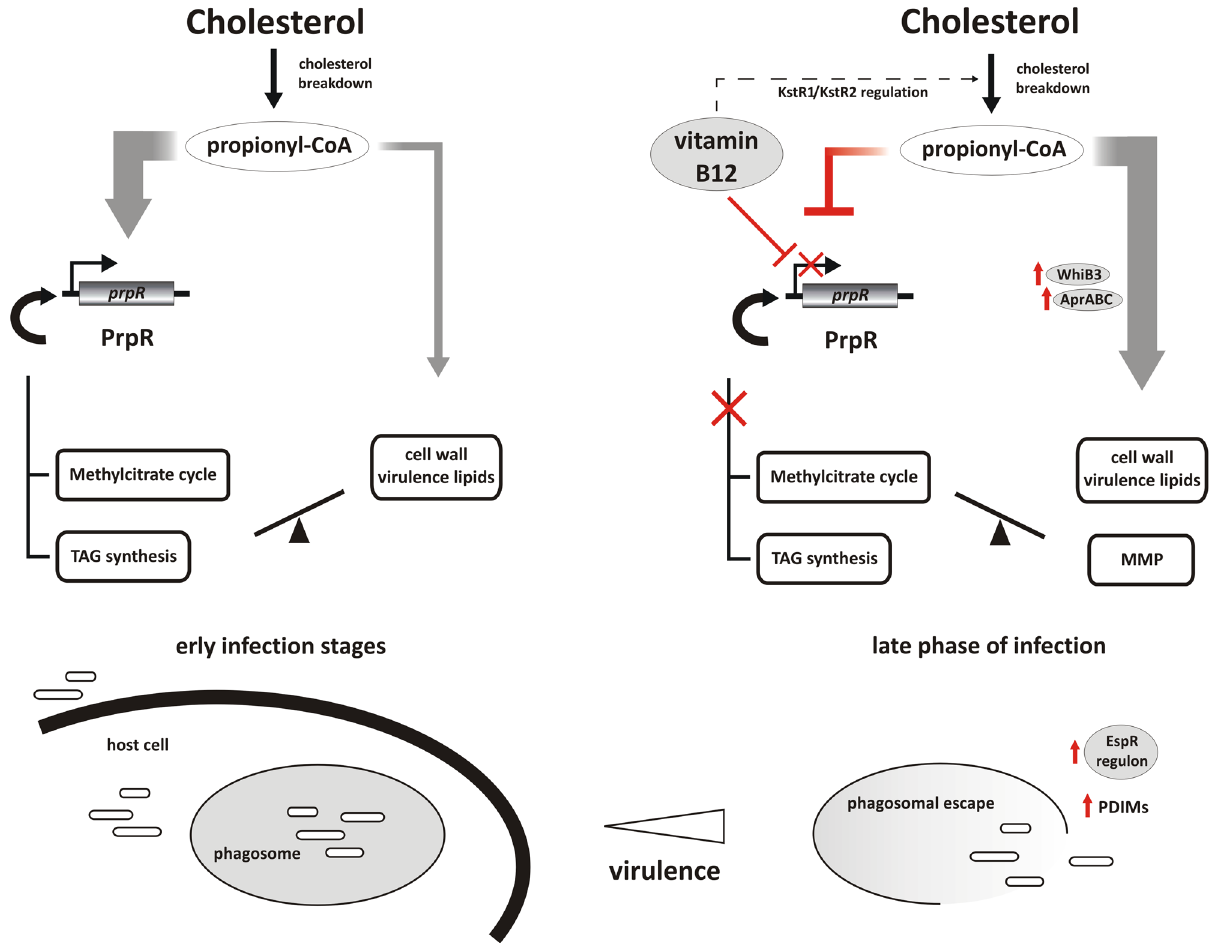
Figure 6. The role of vitamin B 12 and PrpR joint action in the channeling of propionyl-CoA and virulent phenotype induction during Mtb infection. See the text for